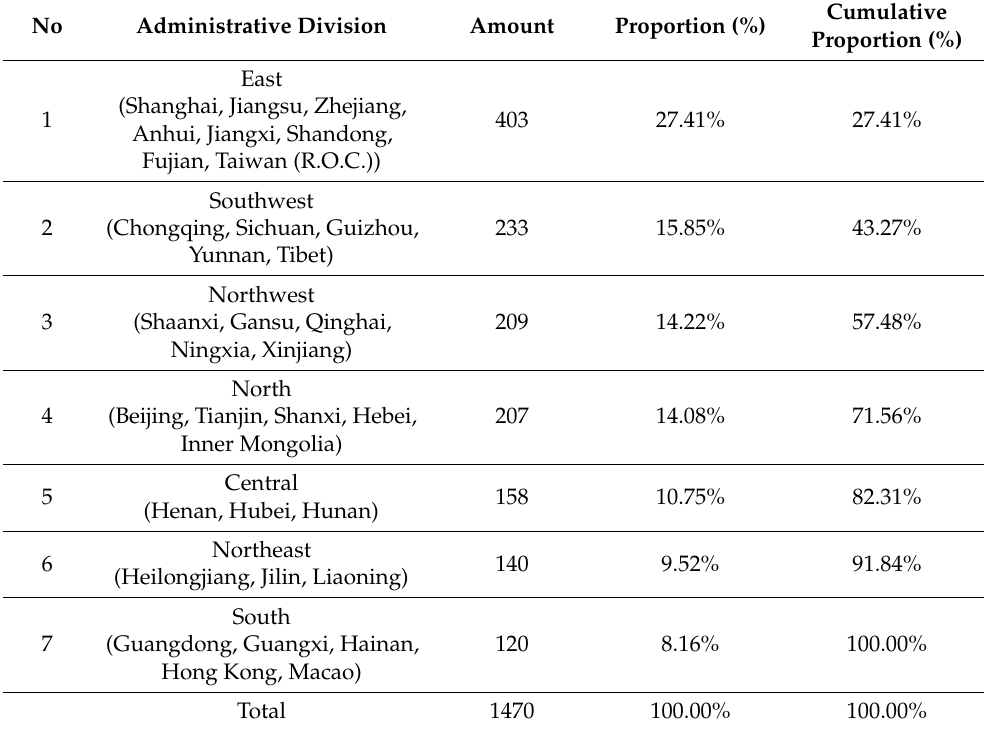
Table 3. Statistics of the distribution of beautiful leisure villages in seven geographical divisions in